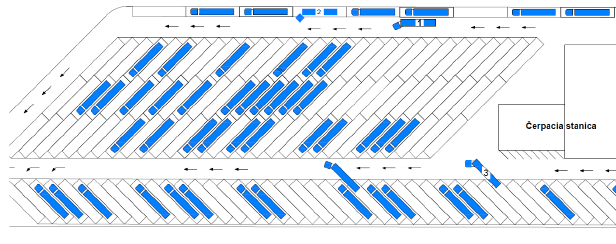
Figure 3. Car park with using of